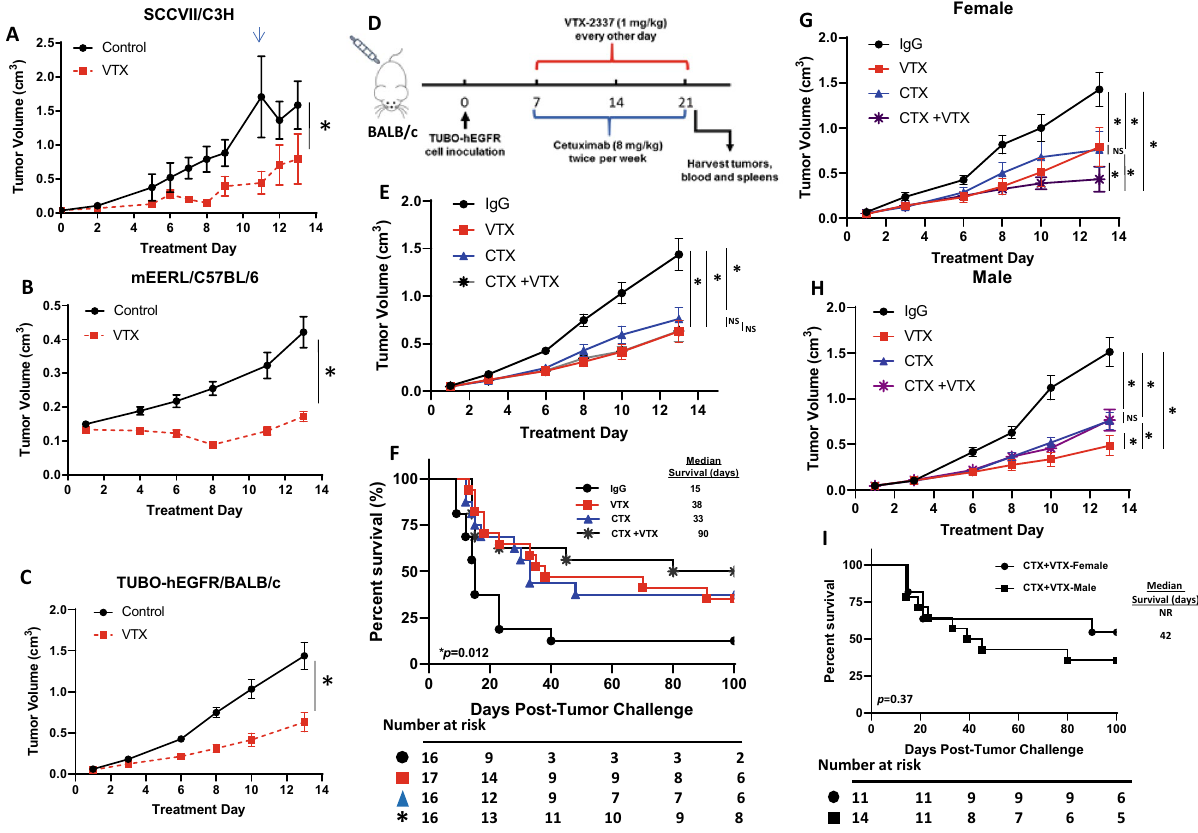
Figure 4. VTX-2337 shows an anti-tumor effect in vivo. ( A – C ) C3H mice bearing SCCVII tumors ( A ), C57BL/6 mice bearing mEERL ( B ), and BALB/c mice bearing TUBO-hEGFR tumors ( C ) were treated with PBS (Control) or VTX-2337 (VTX) and tumor growth was measured. Arrow in ( A ) represents the time at which tumor growth in a control-treated mouse reached euthanasia criteria. N = 5–9 mice/treatment group. ( D ) VTX and cetuximab (CTX) treatment schema. ( E – I ) BALB/c mice (n = 10 mice/group, 5 male/5 female) bearing TUBO-hEGFR tumors were treated as in ( D ) with IgG + PBS used as controls. Separate tumor growth graphs are shown for male ( F ) and female ( G ) mice from E. Error bars represent standard error of the mean. ( H – I ) Shown are Kaplan Meier curves comparing overall and median survival of all mice ( H ) and CTX + VTX-treated mice from H separated into female and male (I). *p < 0.05. NS: non-significant (Linear